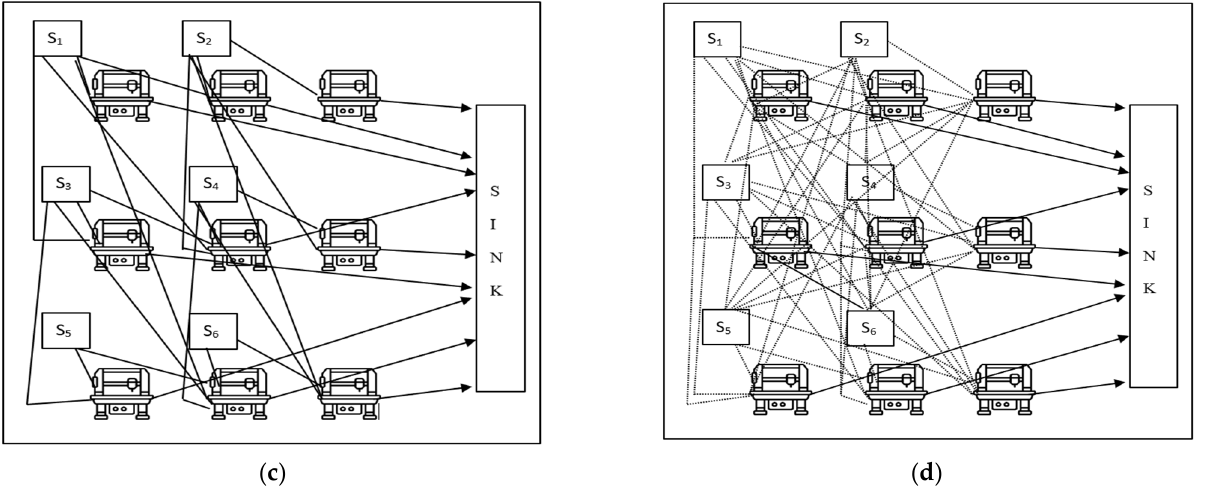
Figure 3. Flexible-configuration machine systems. ( a ) One-degree flexible system. ( b ) Two-degree flexible system. ( c ) Semi-flexible system. ( d ) Fully flexible system.